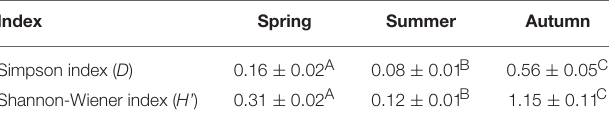
TABLE 3 | Diversity index in different